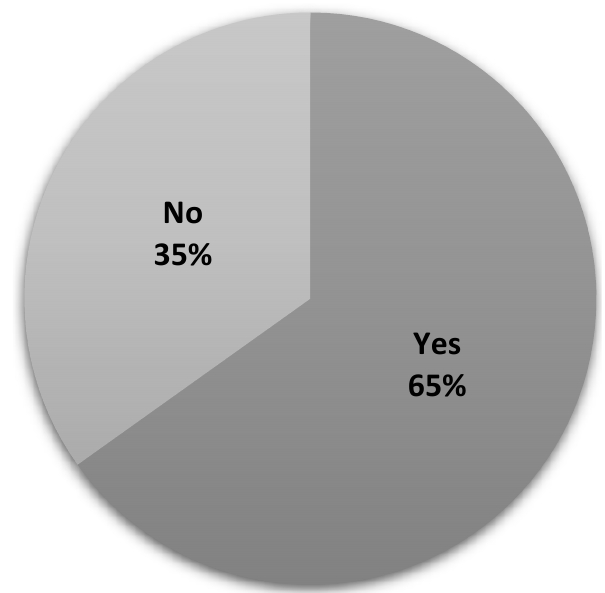
Figure 1. Frequency of students with controlled asthma.